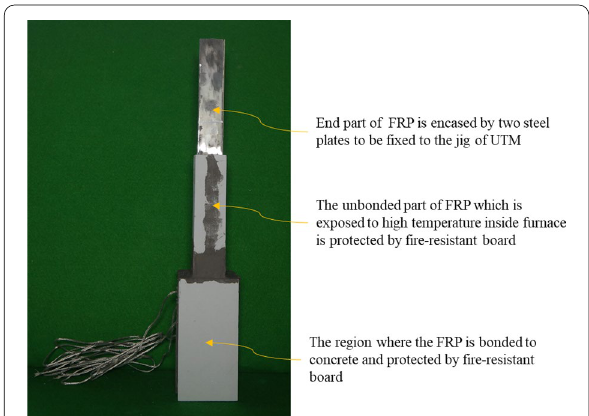
Fig. 7 Shape of test specimen before installation in heating furnace.